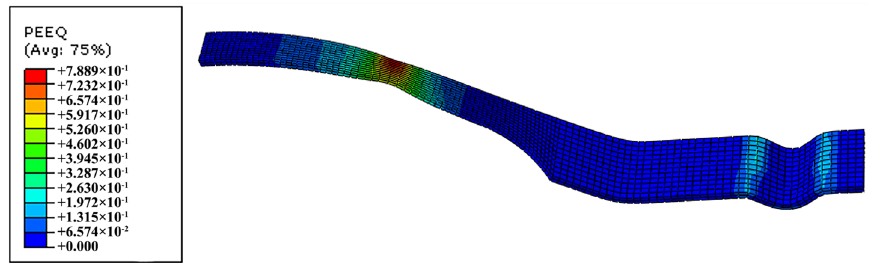
Figure 1. Simulation result of equivalent strain in uniaxial tension.